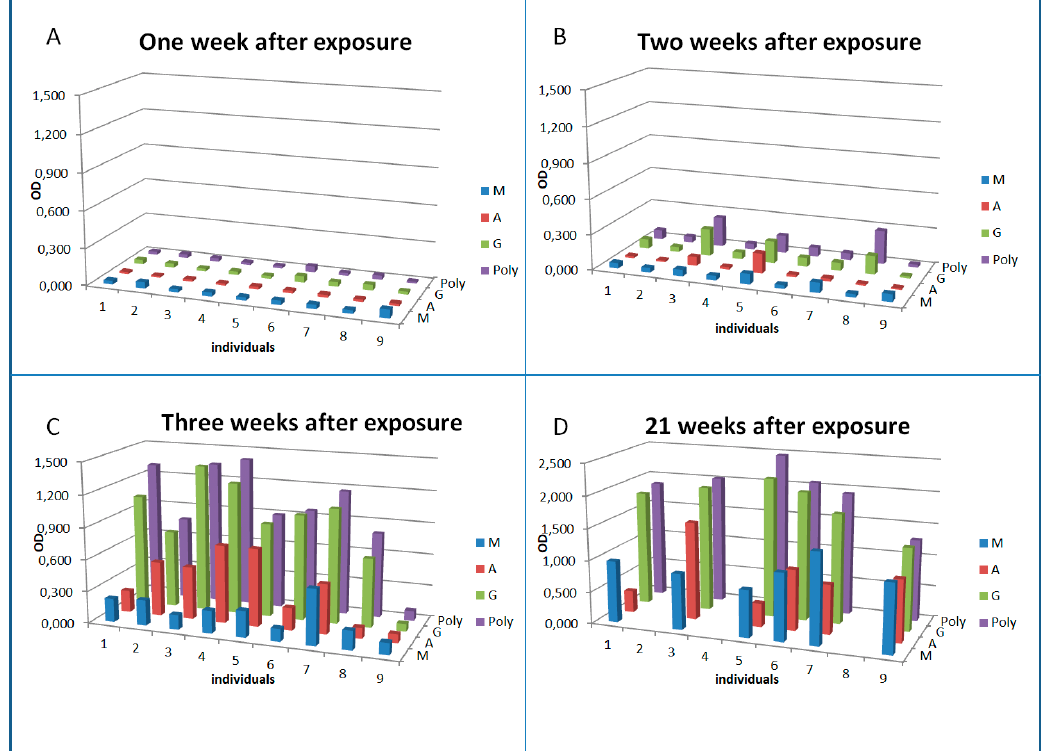
Figure 1. Seroconversion and dynamics of antibody isotypes against F. tularensis in patients treated early with antibiotics. Sera from nine patients diagnosed with acute tularemia were analyzed by ELISA. For sampling time points 1–3 (( A ) sampled on 4th November 2018, one week after exposure; ( B ) sampled on 8th November 2018, two weeks after exposure; ( C ) sampled on 14th November 2018, threeweeks after exposure), sera from all nine patients were available. For sampling time point 4 (( D ) sampled in April / May 2019, 21 weeks after exposure), only sera from six patients were available. Exposure date was 27th October 2018 and patients were admitted with clinical signs to the hospital on 1st November 2018. The validated diagnostic cut-offs of this assay are: positive OD > 0.6, borderline OD 0.25–0.6, negative < 0.25.